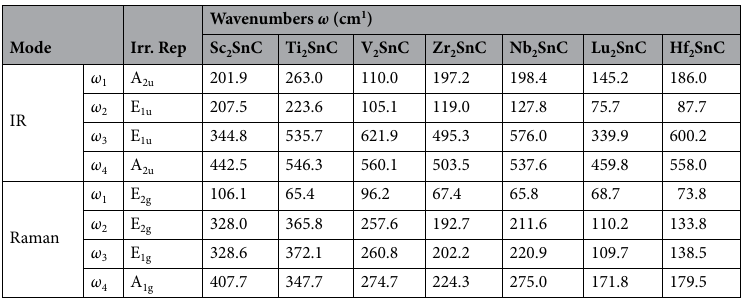
Reaction (V ́ denotes